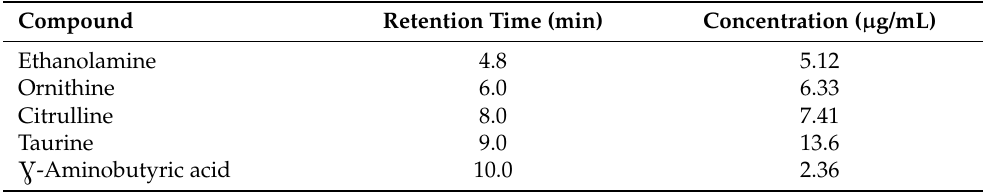
Table 3. HPLC analysis of non-protein nitrogenous compounds in CSW used in the current